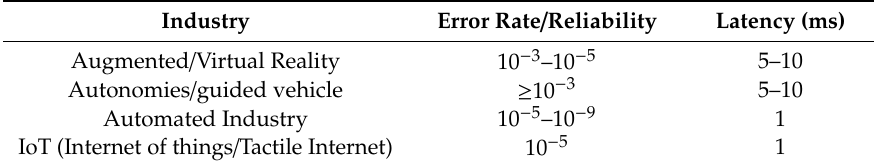
Table 3. Expected quality of service (QoS) requirements for URLLC [7,12].